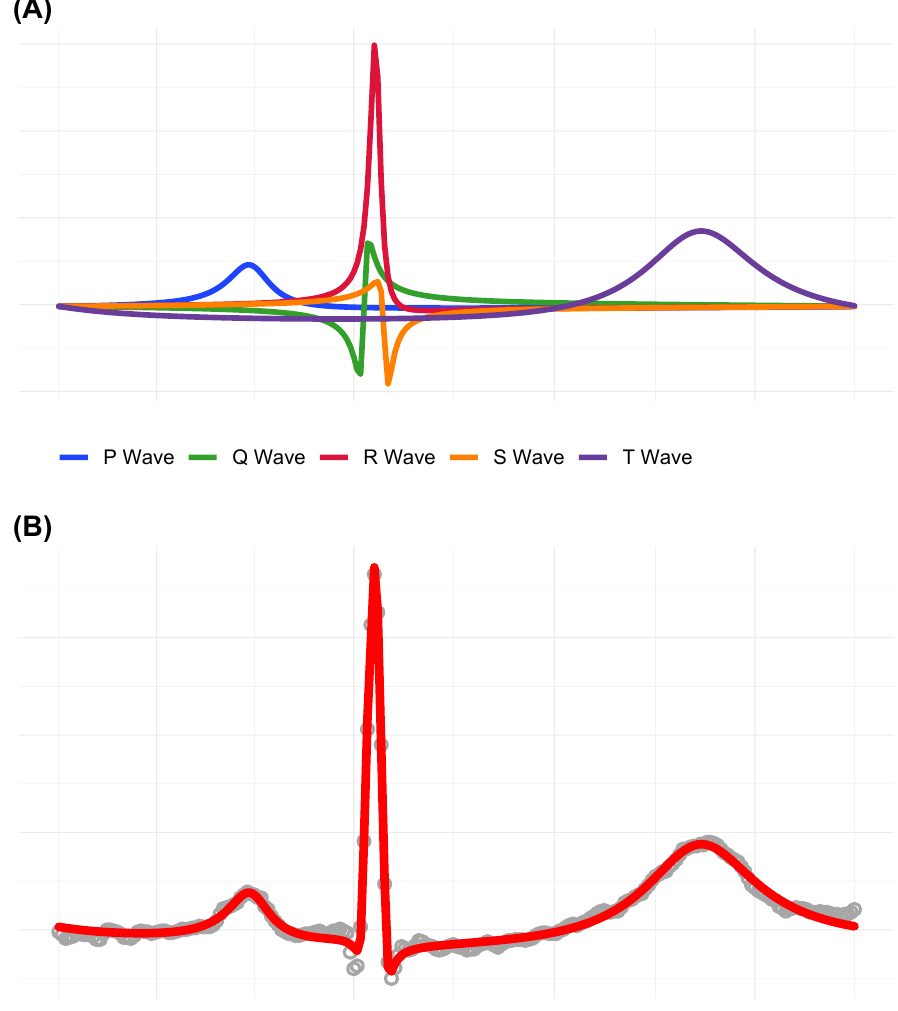
Figure 2. A typical heartbeat of the patient sel 230 from QT database in Physionet ATM Bank. ( A ): the five individual waves. ( B ): the predicted FMM ecg